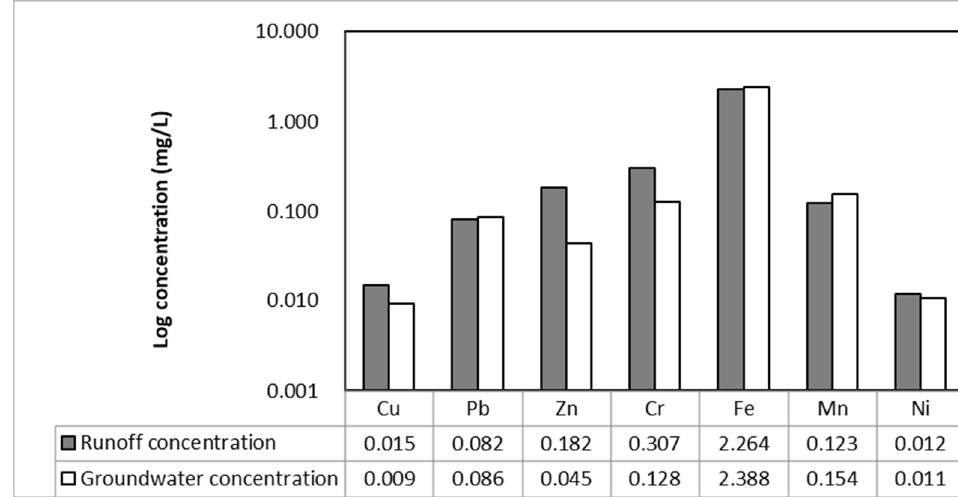
Figure 7. Comparison of average groundwater and runoff concentrations.